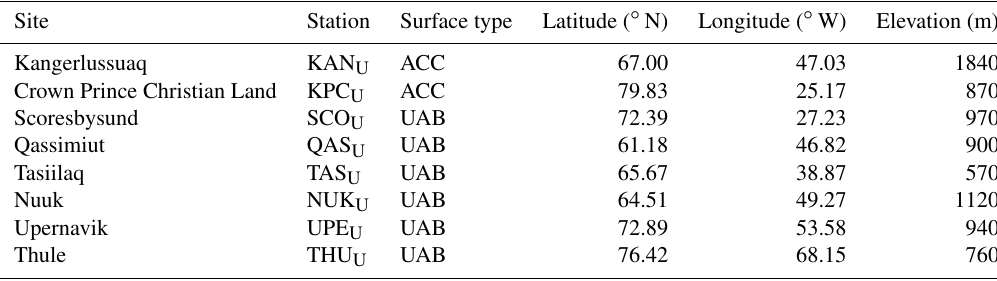
Table 2. PROMICE observation sites including the surface type, co-ordinates and elevation.